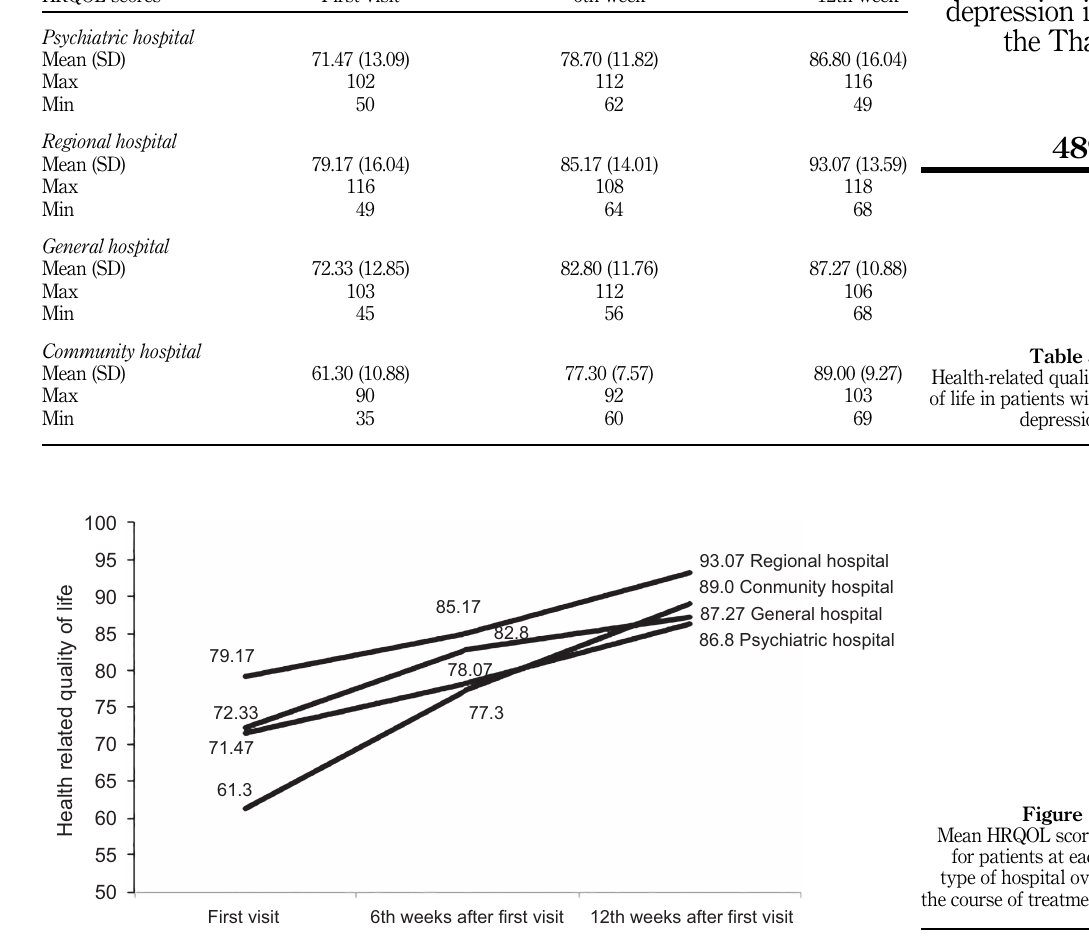
Figure 1. Mean HRQOL scores for patients at each type of hospital over the course of